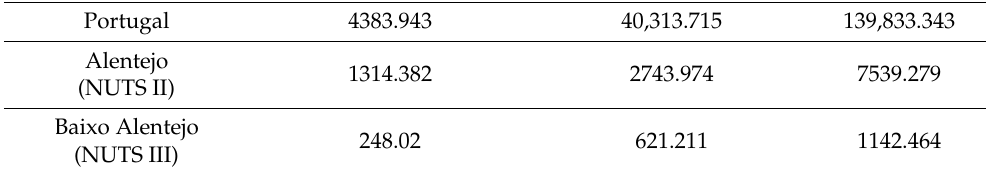
Table 1. Economic outlook by geographic localization (NUTS 2013) and activity branch. Source: INE (2021). Agriculture, Animal Industry, Construction, Sectors of Activity Production, Hunting, Energy and Water Territory Forestry and Fishing